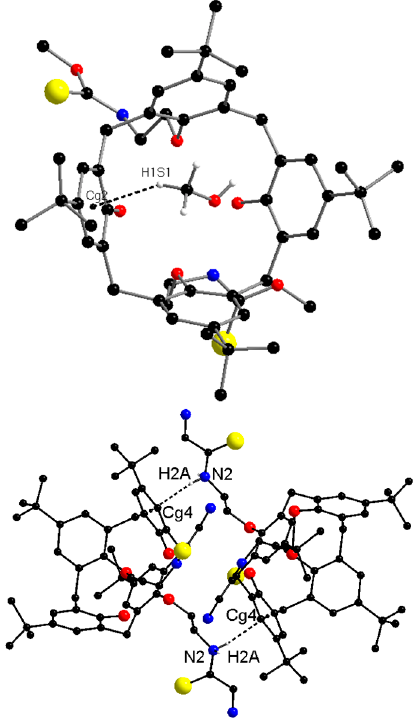
Figure 6. View of intermolecular interactions in compound ( 4 ): ( top ) Cavity and a methanol molecule through interaction of C-H ∙∙∙π . ( bottom ) N-H ∙∙∙π interactions. The H-atoms not involved in the intermolecular interactions have been omitted for clarity.